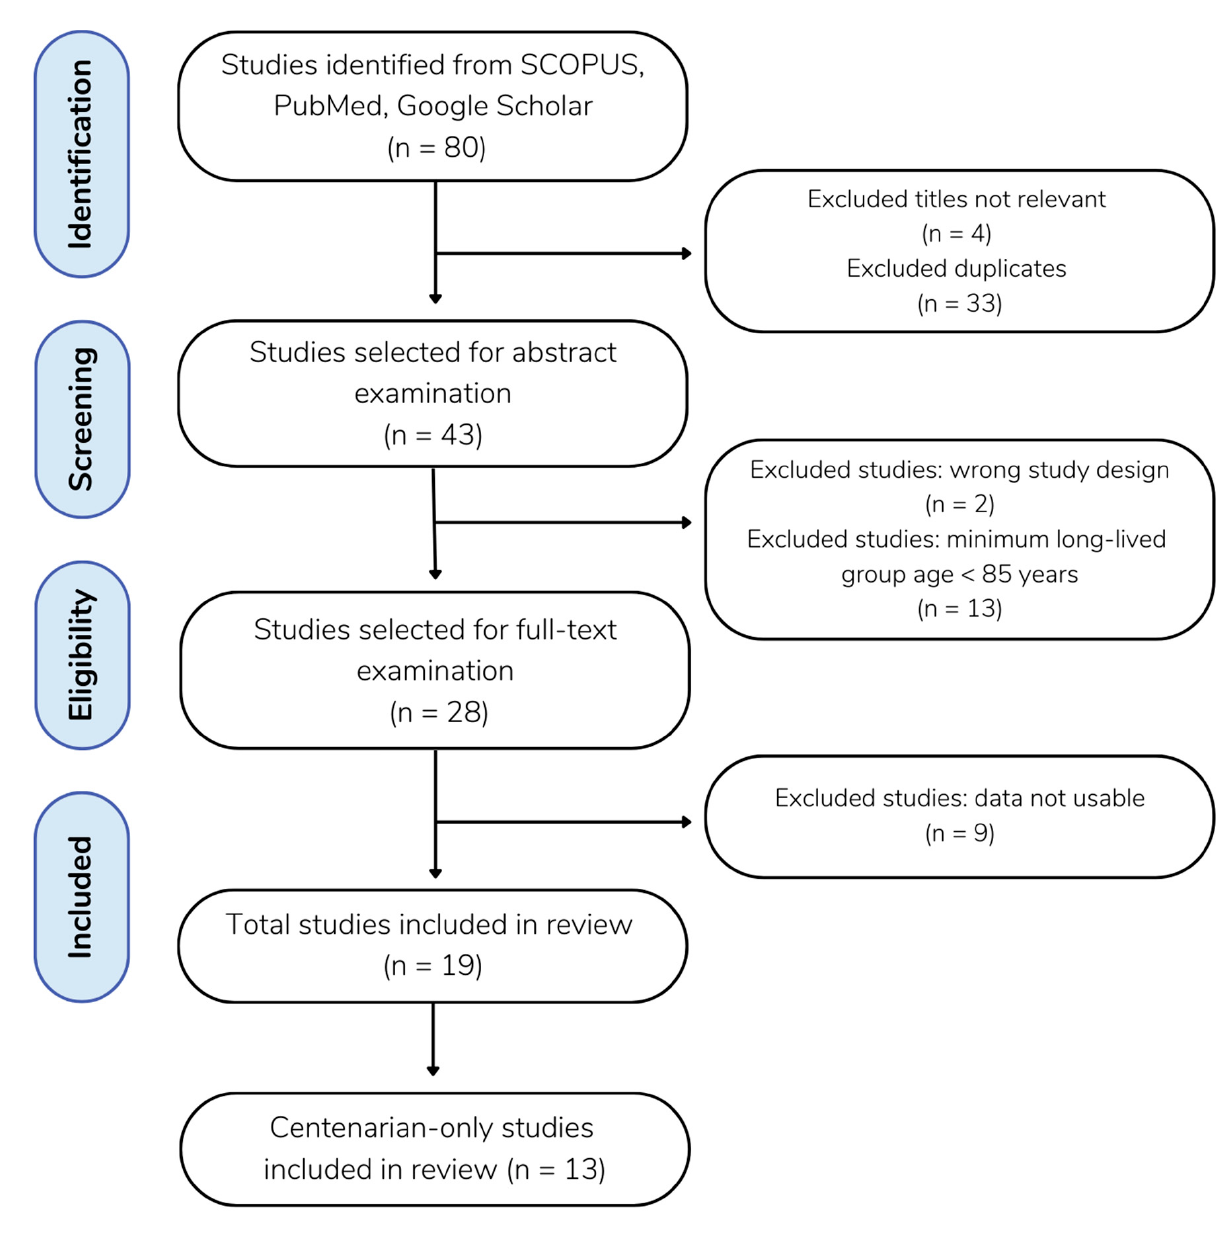
Figure 1. Flow diagram of the literature search. A total of 80 studies were gathered from SCOPUS (n = 39), PubMed (n = 26), and Google Scholar (n = 15). Excluding 33 duplicates and 4 studies with